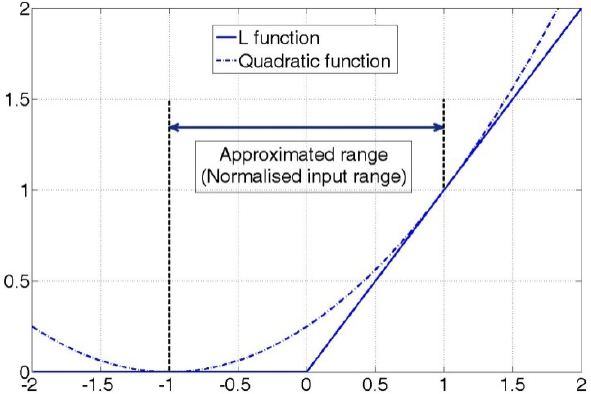
Figure 7. Loss function L and an approximated quadratic